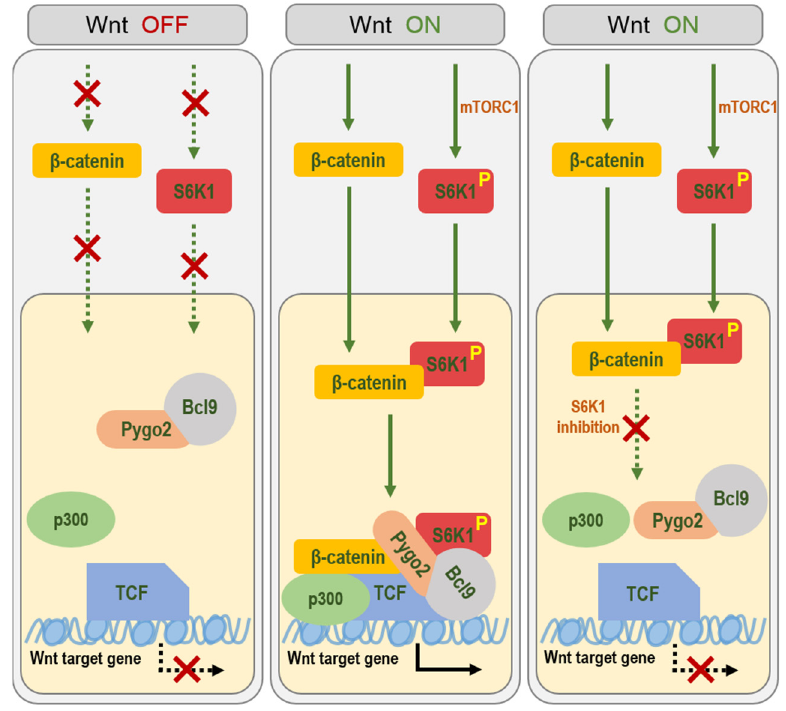
Figure 7. A mechanistic model.